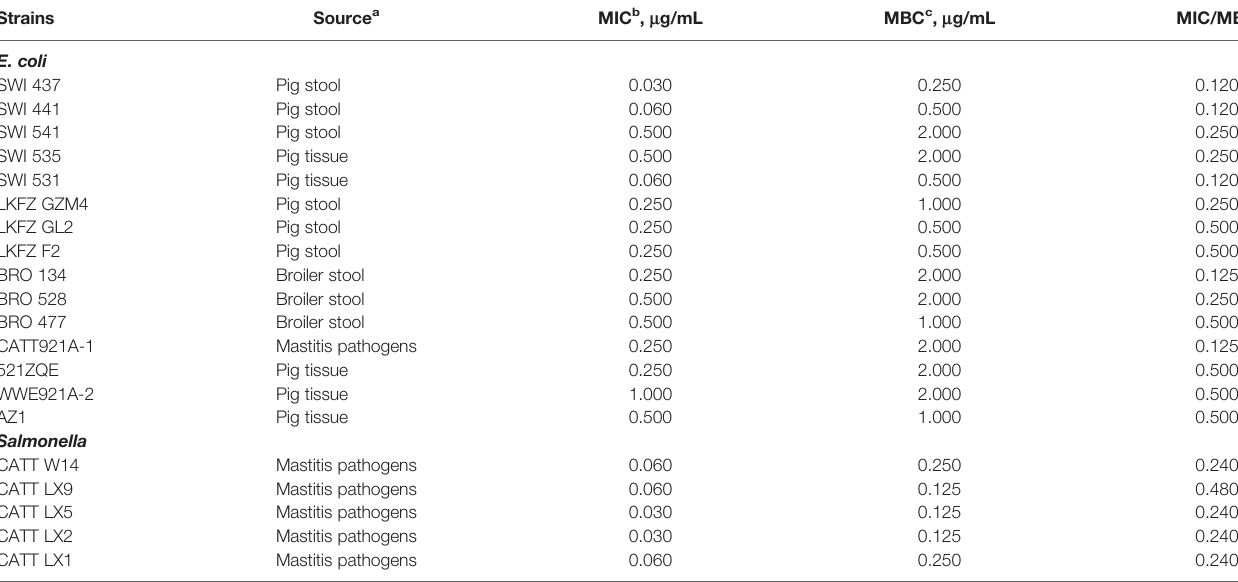
TABLE 2 | MIC and MBC of antimicrobial peptide MccJ25 among clinical isolates.